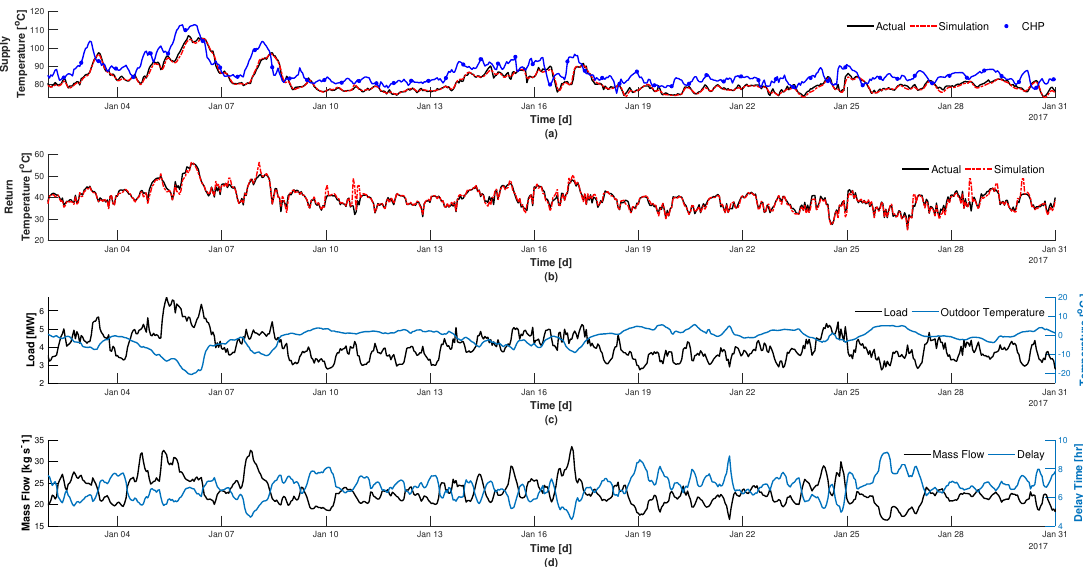
Figure 4. Validation of DHN model: ( a ) temperature supplied to Tillberga in comparison to the temperature being supplied from the CHP, ( b ) return temperature to CHP from Tillberga, ( c ) load and outdoor temperature, ( d ) mass flow rate and delay